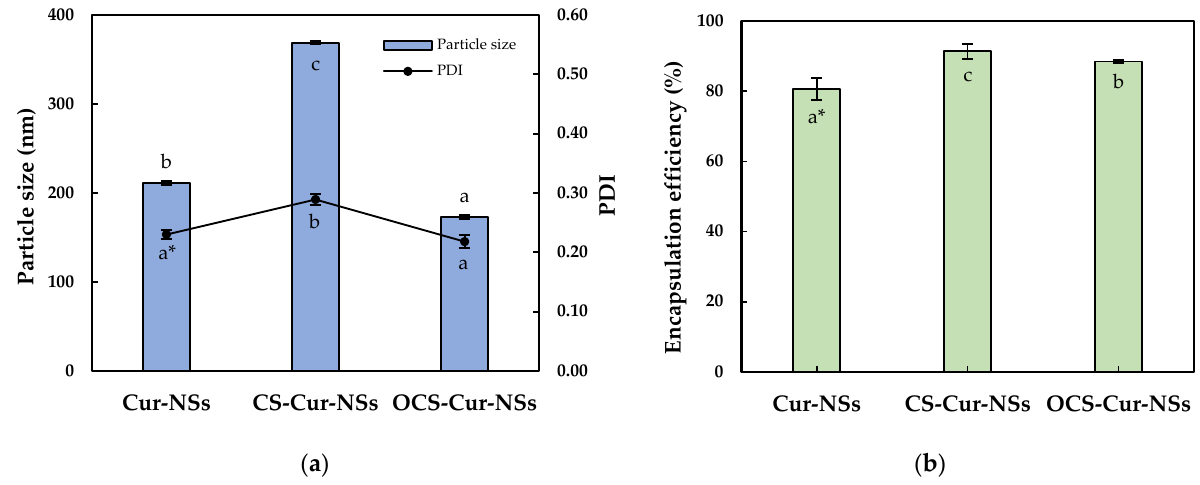
Figure 1. Particle size and PDI ( a ) and encapsulation efficiency ( b ) of Cur-NSs, CS-Cur-NSs and OCS-Cur-NSs. * Different letters in the same variable indicate a significant difference at p < 0.05. Error bars indicate the standard deviation.